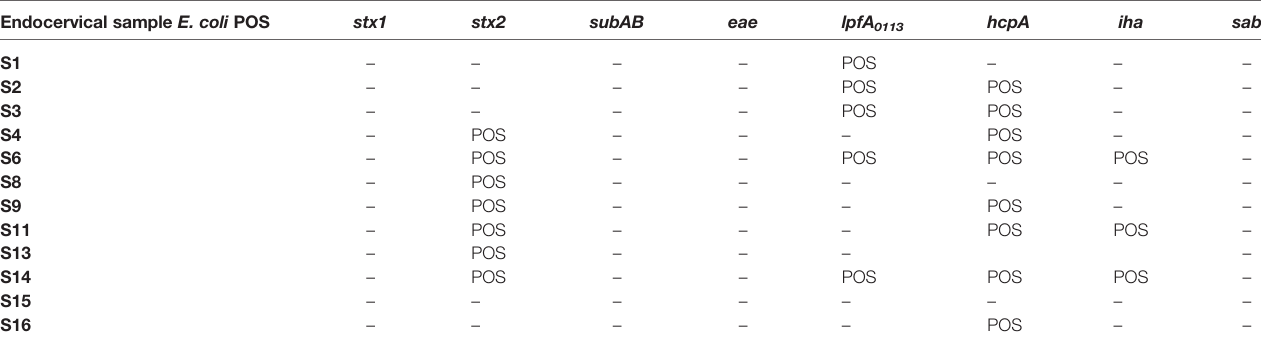
TABLE 4 | Genotypic identi fi cation of STEC virulence factors in E. coli -positive samples . Endocervical sample E. coli POS